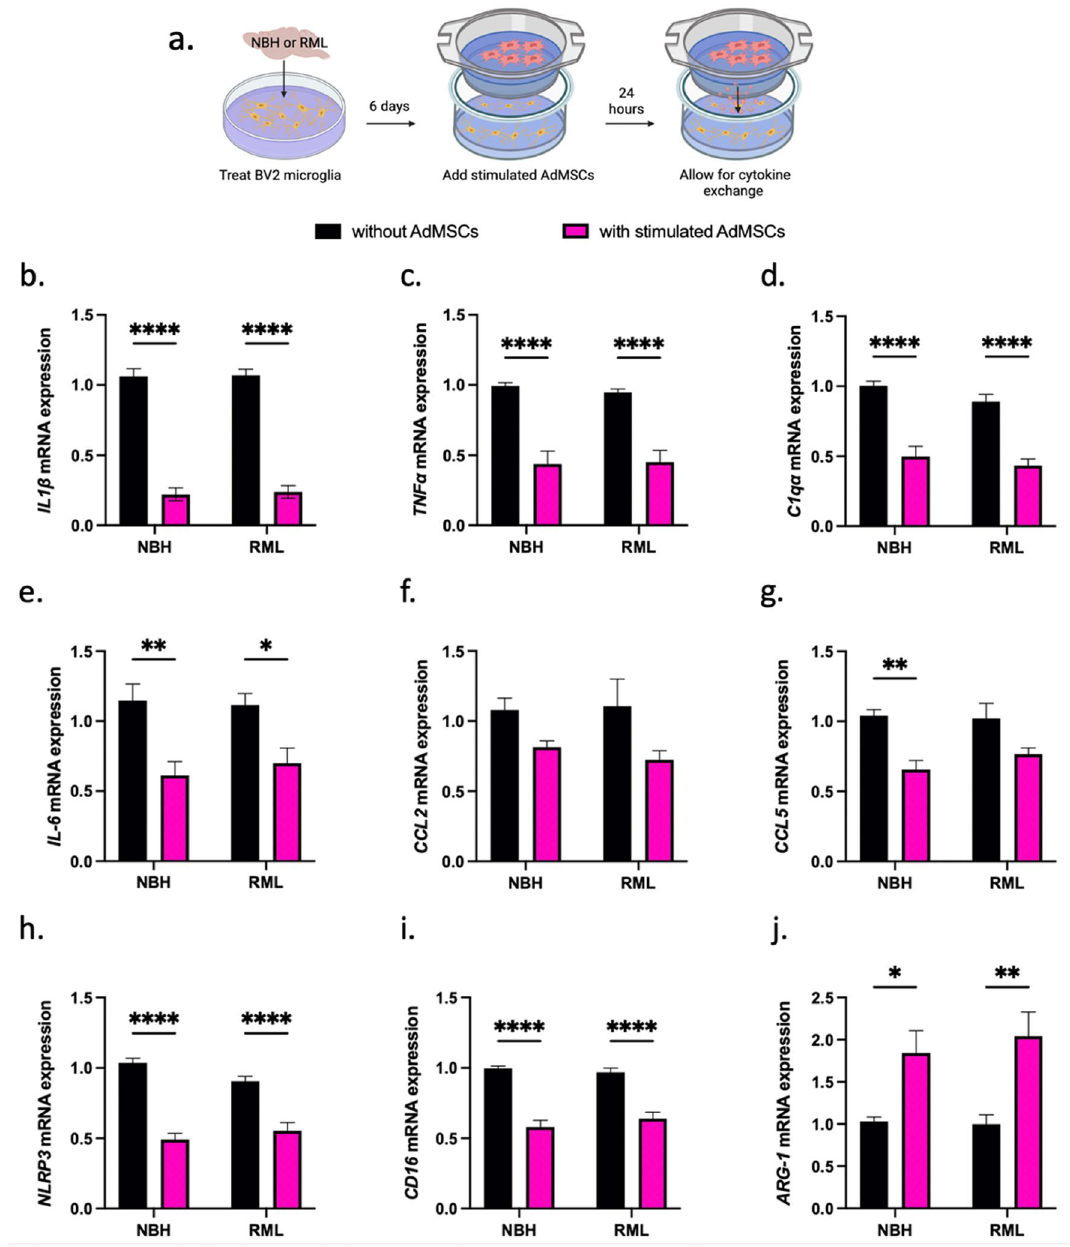
Figure 3. Stimulated AdMSCs decrease inflammatory phenotypes in BV2 microglia. ( a ) BV2 microglia were exposed to RML prion brain homogenate or normal brain homogenate (NBH) for 6 days, then co-cultured for 24 h with TNFα-stimulated AdMSCs. This resulted in a decrease in inflammatory cytokines ( b ) IL1β, ( c ) TNFα, ( d ) C1qα, and ( e ) IL-6. No significant change was seen in ( f ) CCL2 and a decrease was seen only in the NBH treatment for ( g ) CCL5. A decrease was seen in mRNA for the ( h ) NLRP3 inflammasome and for M1 marker ( i ) CD16. An increase was seen for the M2 marker ( j ) Arg-1. Three biological replicates, with three technical replicates, all analyses normalized to β-actin . Two-way ANOVA and post-hoc Tukey test, error bars = SEM, * p < 0.05, ** p < 0.01, *** p < 0.001, **** p < 0.0001. Graphic created with